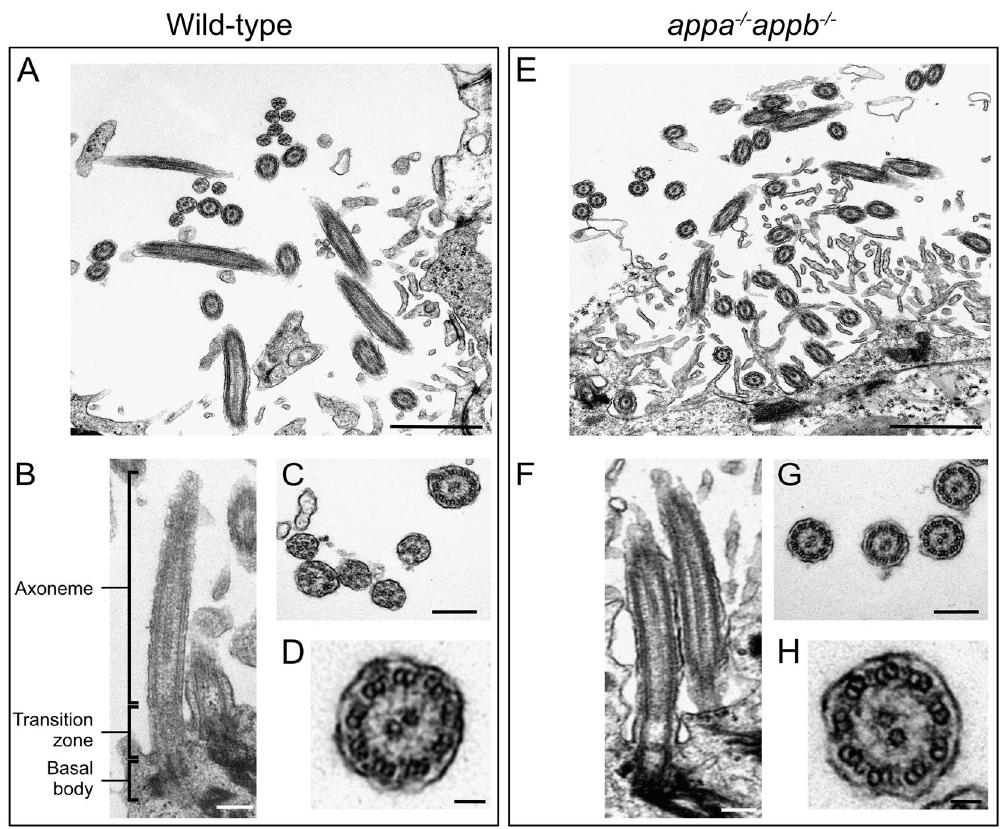
Figure 8. Structural integrity of ependymal cilia in WT and appa −/− appb −/− zebrafish. Transmission electron microscopy of adult zebrafish ependymal cilia of WT ( A – D ) and appa −/− appb −/− mutant ( E – H ) adult zebrafish. ( A , E ) Overview of ependymal cilia of the central canal. ( B , F ) Longitudinal view on the axoneme of the cilia composing its core, the transition zone including the ciliary pit between the cilia core and the cellular membrane and the basal body containing the cilia centrioles, highlighted with increased signal. In ( C , G ), cross-sections of cilia. ( D – H ) Zoom on cross-section of individual cilia showing (9 + 2) microtubule doublet organization. Scale bar: ( A , E ) = 1 µm, ( B , C , F , G ) = 200 nm, ( D , H ) = 50